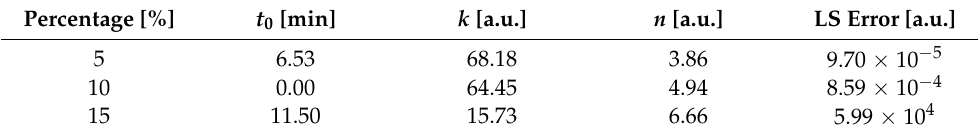
Table 1. Weighted least squares fitting